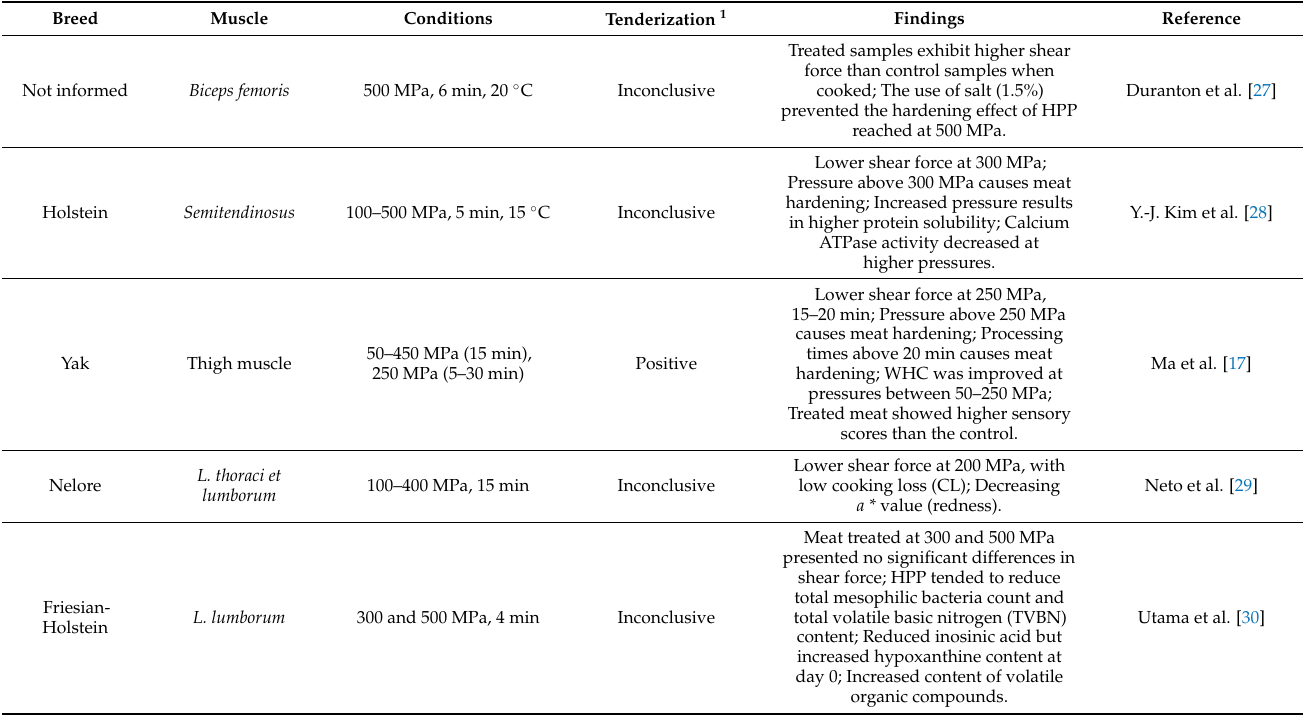
Table 2. Detailed description of the HPP papers included in this